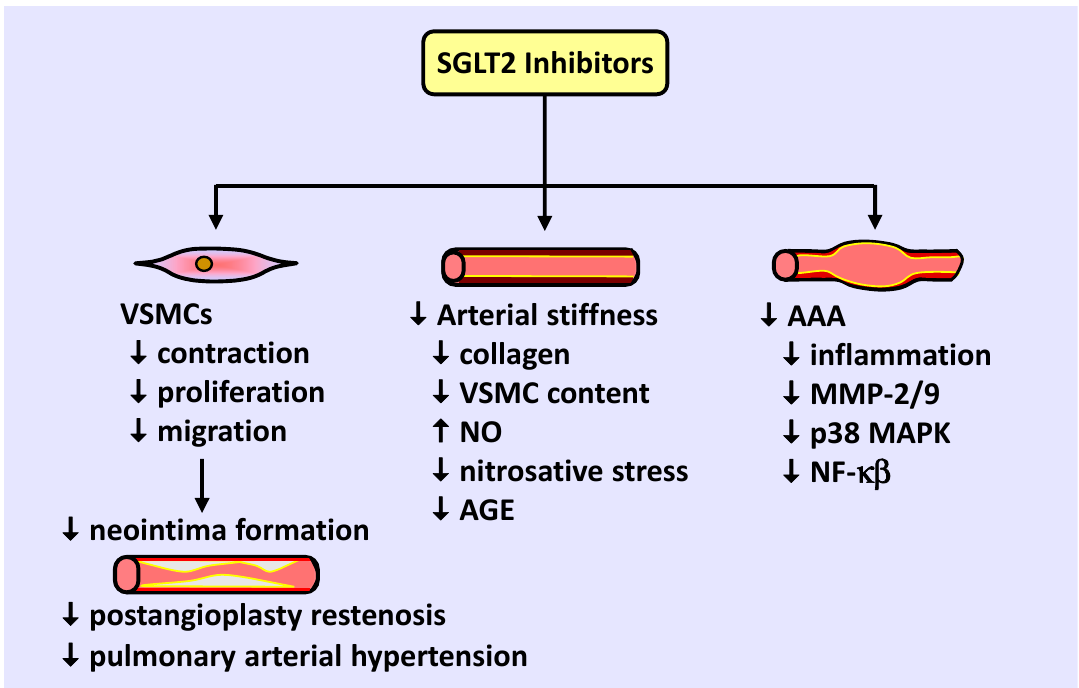
Figure 2. Effect of SGLT2 inhibitors on VSMC function and arterial remodeling. SGLT2 inhibitors block VSMC contraction, proliferation, and migration, leading to vasodilation and diminished neointima formation following coronary angioplasty or in pulmonary arterial hypertension. In addition, SGLT2 inhibitors attenuate arterial stiffening by depressing collagen deposition, VSMC accumulation within the vessel wall, nitrosative stress, and AGE expression, and raising NO levels. SGLT2 inhibitors also reduce abdominal aortic aneurysm formation by blocking vascular inflammation and MMP-2/9 activity, possibly through inhibition of p38 MAPK and NF- κ B activation.